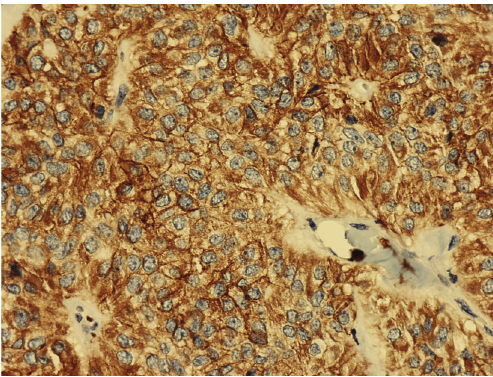
Figure 1: Endoscopic ultrasound of the hypoechoic lesion in the pancreatic head.